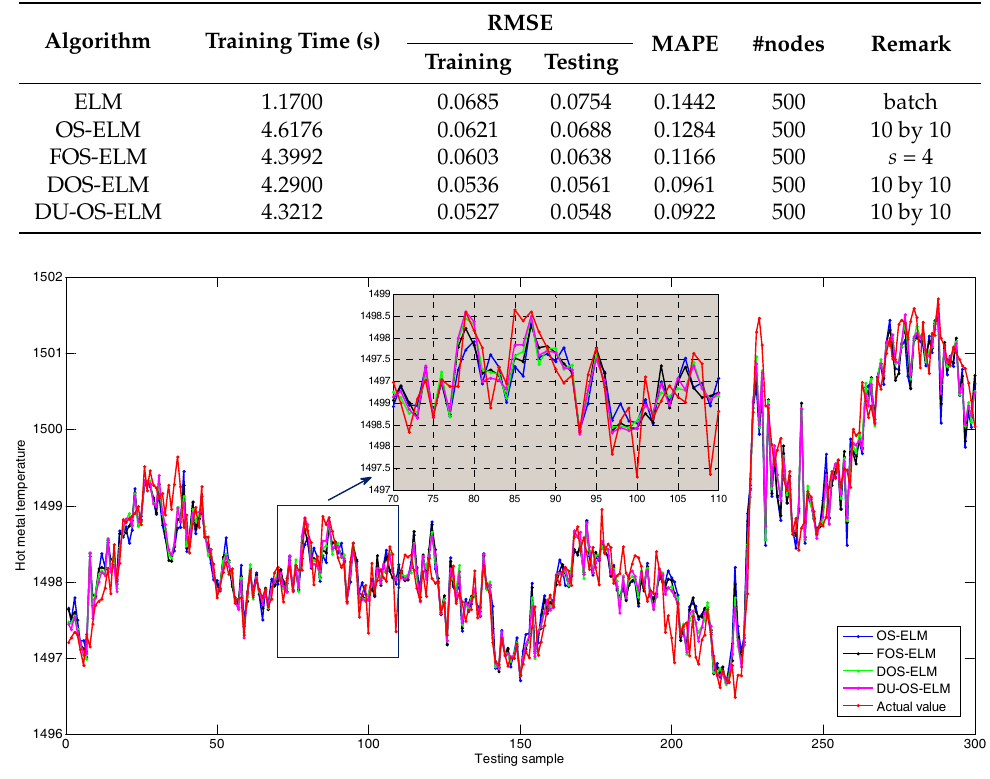
Figure A4. Prediction results of hot metal temperature based on different algorithms.